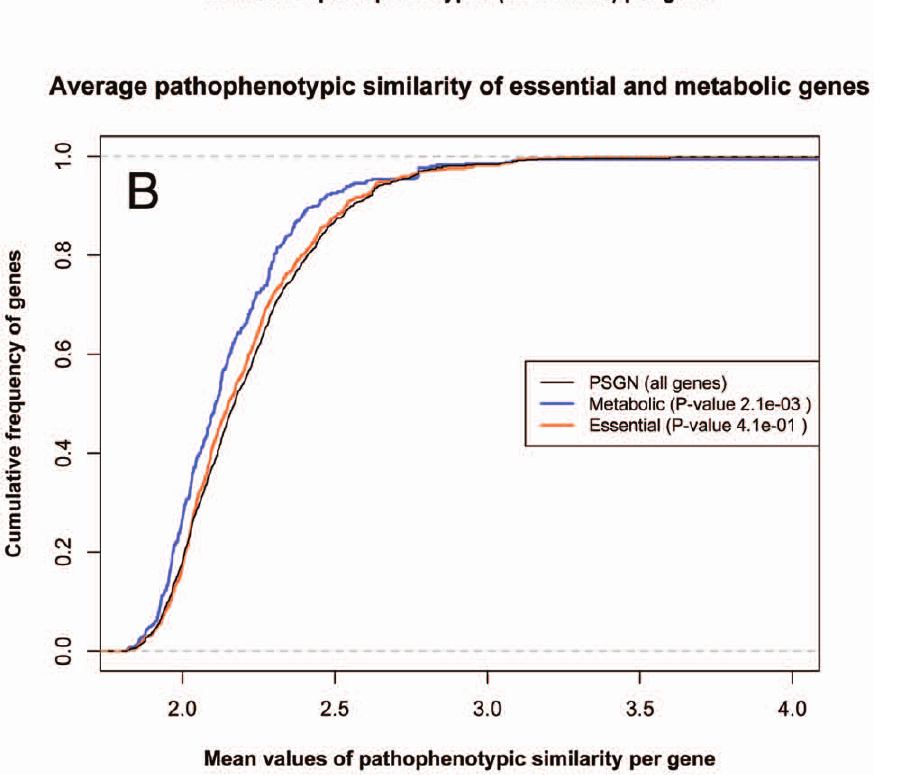
Figure 6. Distributions of the number of pathophenotypes and the pathophenotypic similarities for metabolic and essential genes. Metabolic genes (orange line), essential genes (orange line) and the PSGN (Black line). Upper panel (A) represents the cumulative frequency of the number of specific pathophenotypes annotated for genes, the whole set of genes in HPO (PSGN) was used as the reference distribution. Lower panel (B) represents the cumulative frequency of the average pathophenotypic similarity associated with genes, the whole set of genes in HPO (PSGN) was used as the reference distribution. The p-values, included in each legend, represent the mean of the resulting p-values after 1000 non-parametric tests (Mann-Whitney test) where every set of metabolic and essential genes was compared, each time, with a random sample of genes in PSGN of the same size of their respective set (see methods).